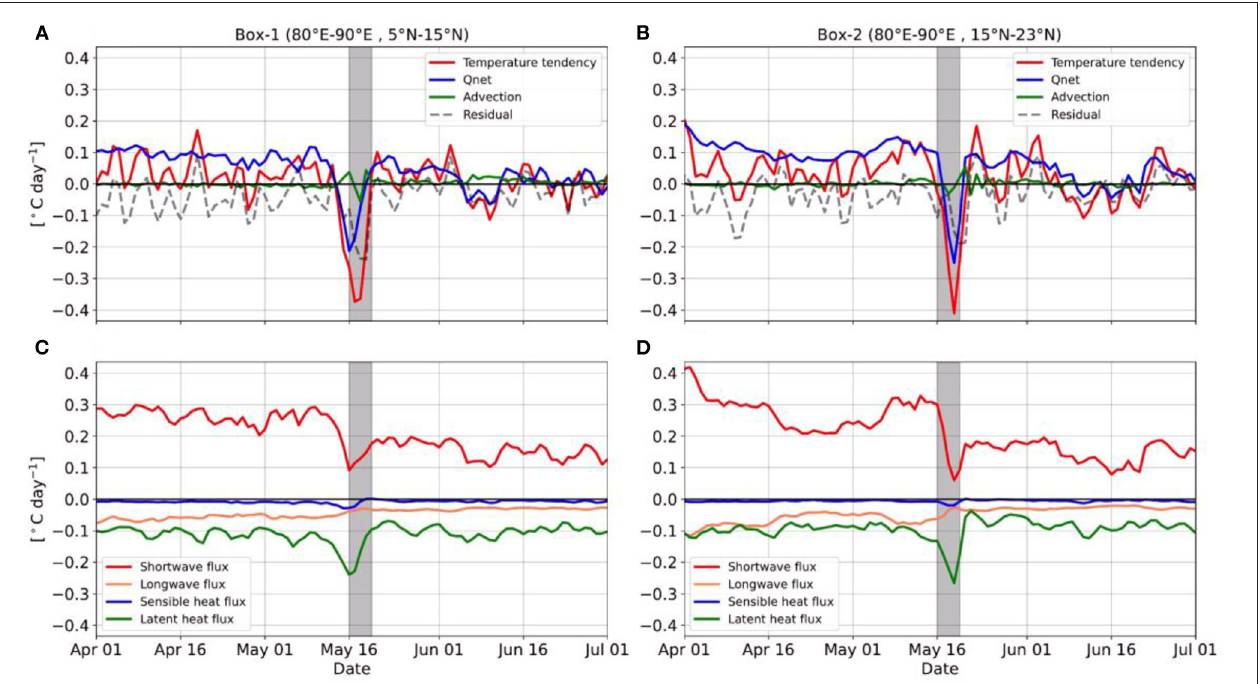
FIGURE 4 | Time series of the mixed layer depth temperature tendency (red, ◦ C day − 1 ), net surface heat flux (blue, ◦ C day − 1 ), advection (green, ◦ C day − 1 ), and residual (gray dash, ◦ C day − 1 ) for (A) box 1, (B) box 2. Time series of net surface shortwave radiation (red, ◦ C day − 1 ), net surface longwave radiation (green, ◦ C day − 1 ), surface sensible heat flux (blue, ◦ C day − 1 ), surface latent heat flux (yellow, ◦ C day − 1 ) for (C) box 1 (D) box 2. The gray shading represents the duration of the tropical cyclone